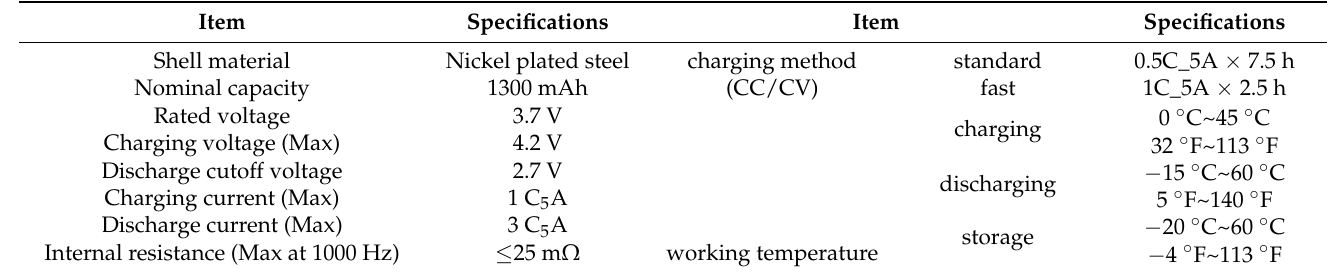
Table 1. Battery’s detailed parameter